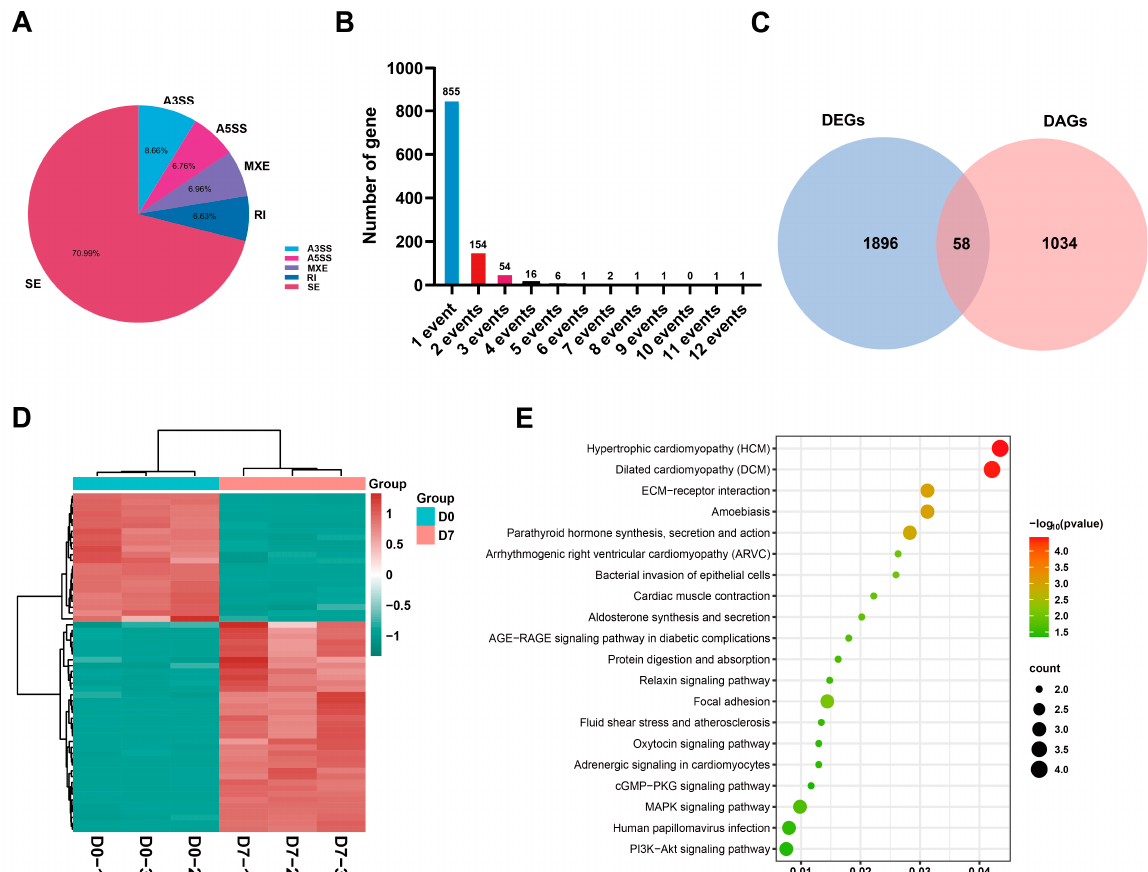
Figure 5. Di ff erential splicing analysis of DEGs between the proliferation stage and di ff erentiation stage of SMSCs. ( A ) Distribution of fi ve AS events. SE: skipped exon, A3SS: alternative 3 ′ splice site, A5SS: alternative 5 ′ splice site, RI: retained intron, MXE: mutually exclusive exons. ( B ) Di ff erential splicing events between proliferation stage and di ff erentiation stage; ( C ) Venn diagram depicting DEGs and DAGs. ( D ) The heatmap of 58 overlapped genes, where red denotes a high level of ex- pression, whereas green denotes a low level of expression; ( E ) KEGG pathways of the overlapping DEGs and DAGs, where the size of the circle indicates the number of annotated di ff erentially ex- pressed genes, and the color represents the − log p value.